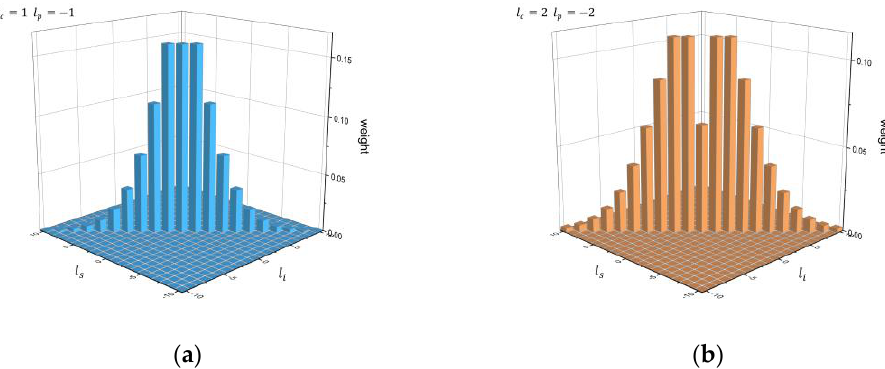
Figure 3. A pump light carrying a topological charge opposite to 𝑙 𝑐 is used to prepare maximally entangled states. ( a ) The normalized spiral spectrum with 𝑙 𝑐 = −𝑙 𝑝 = 1. ( b ) The normalized spiral spectrum with 𝑙 𝑐 = −𝑙 𝑝 = 2 .